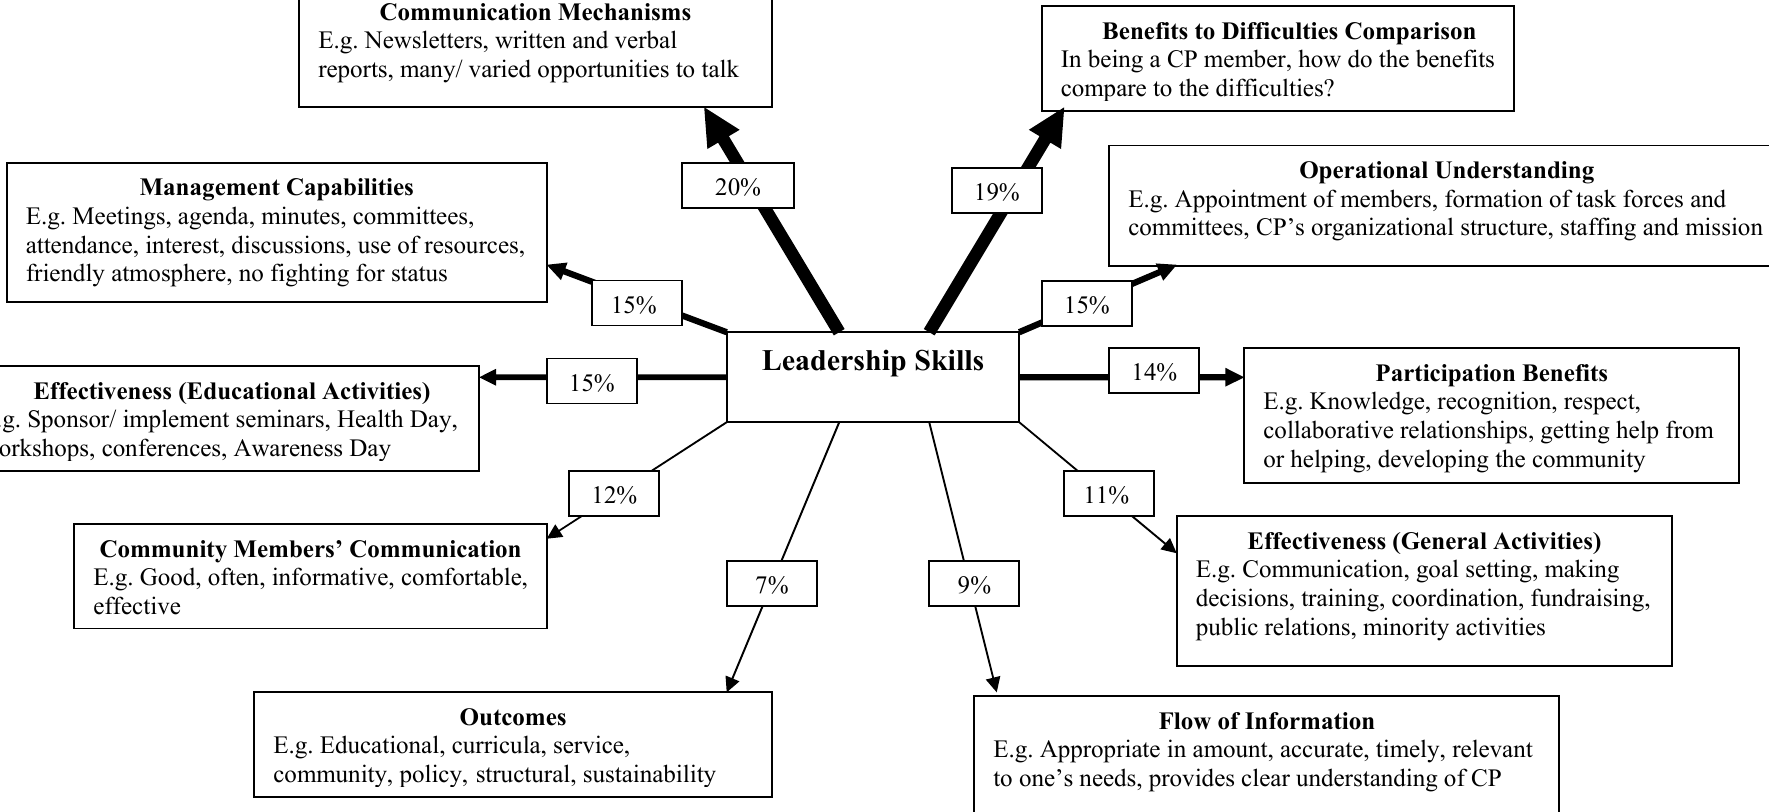
Figure 1. Leadership Skill’s contribution to some Critical Factors across Five